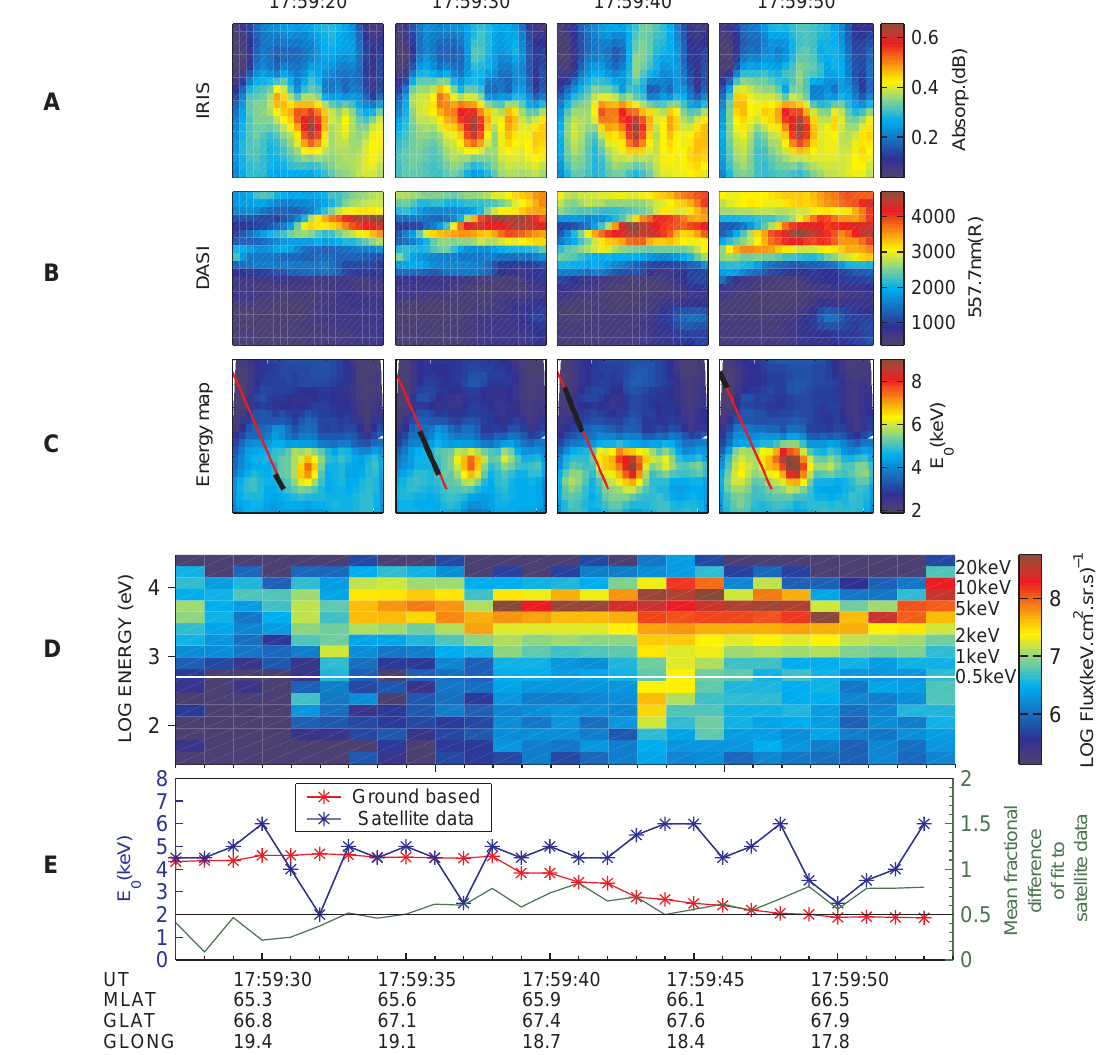
Fig. 3. Same as Fig. 2 but for 6 December 1999, DMSP (F12) and K p =3.